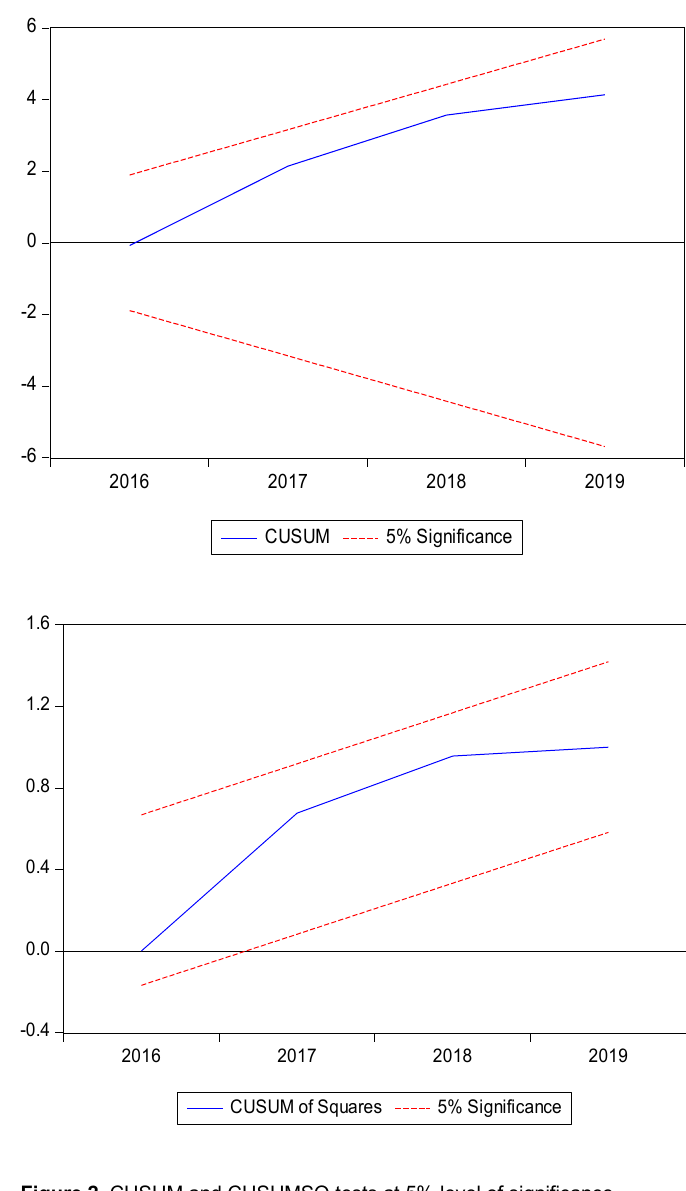
Figure 2. CUSUM and CUSUMSQ tests at 5% level of significance